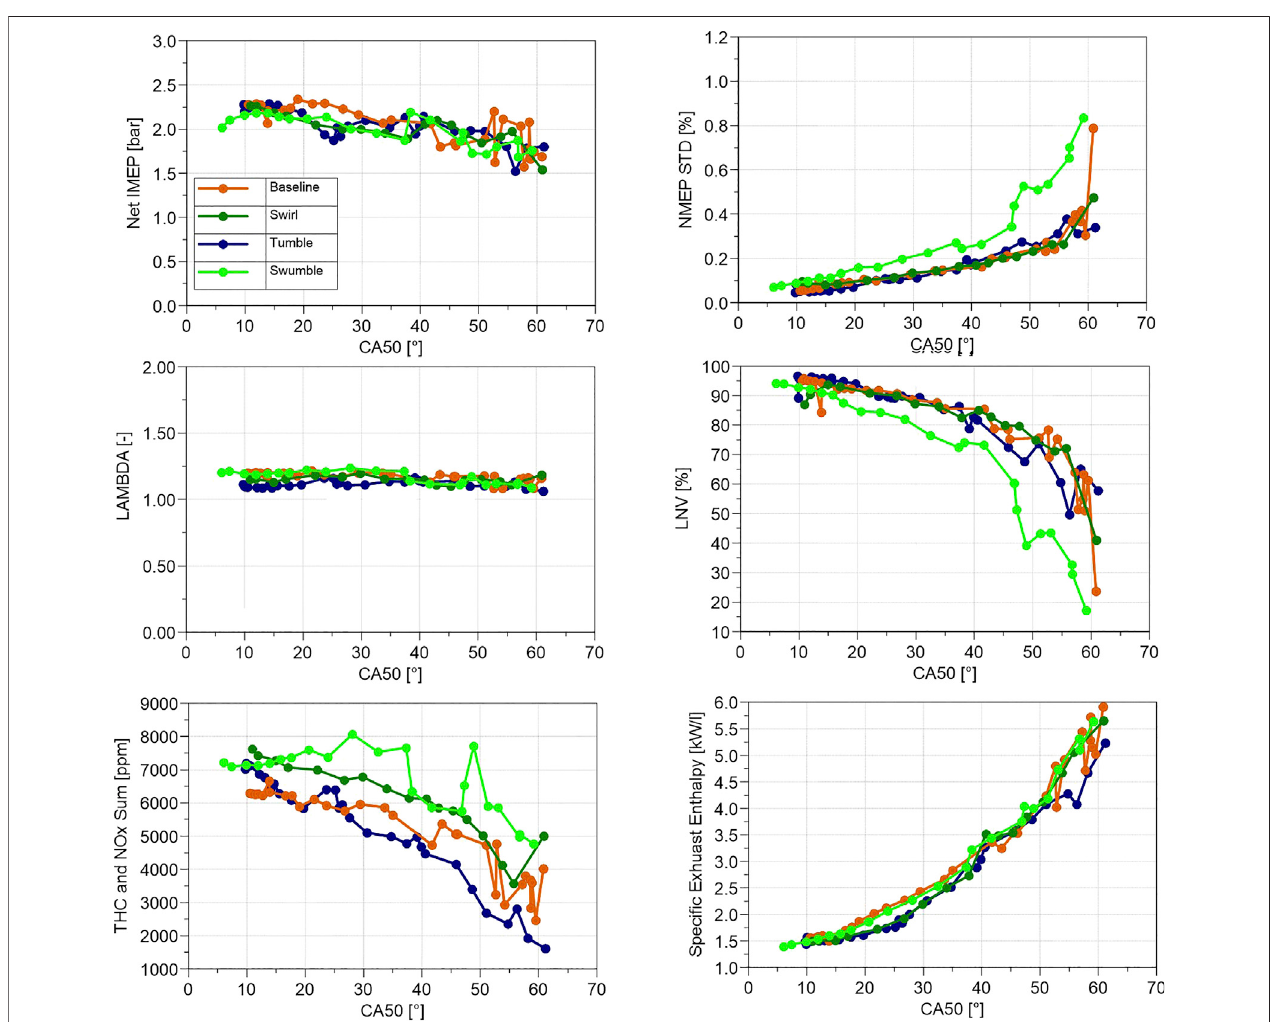
FIGURE 13 | Combustion stability, emissions, and exhaust enthalpy metrics vs. lambda; 1,500 rpm, 2 bar NMEP, 25 ° C fl uids.